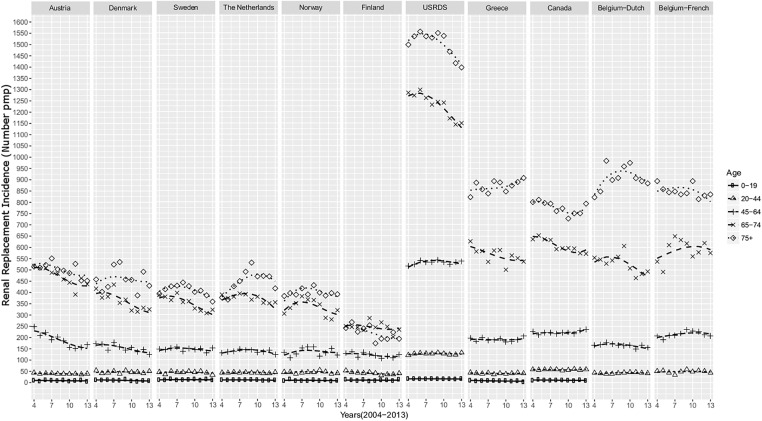
Overall incidence rate pmp*of RRT by country and age category from 2004 until 2013.The symbols represent the actual incidence rate while for each combination of country and age category, a line is included to show an estimated change over the years. For the estimation, the incidences are modelled with polynomial regression on the year, the age category and the country. *pmp: per million population.